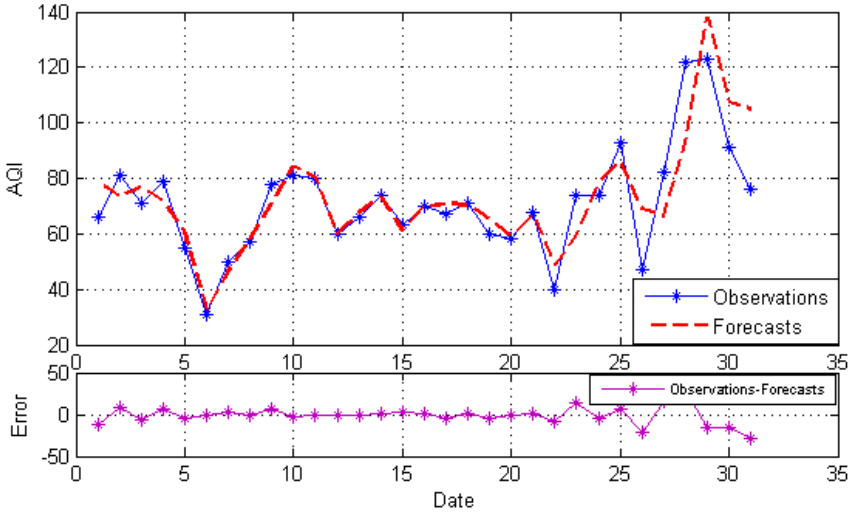
Figure 8. The forecasts and error based on EEMD-MM-CFM.